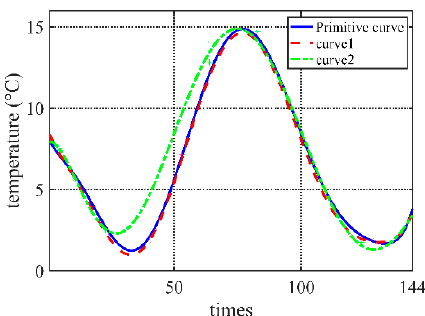
Figure 1. Comparison of fitted curves in different acquisition frequencies.